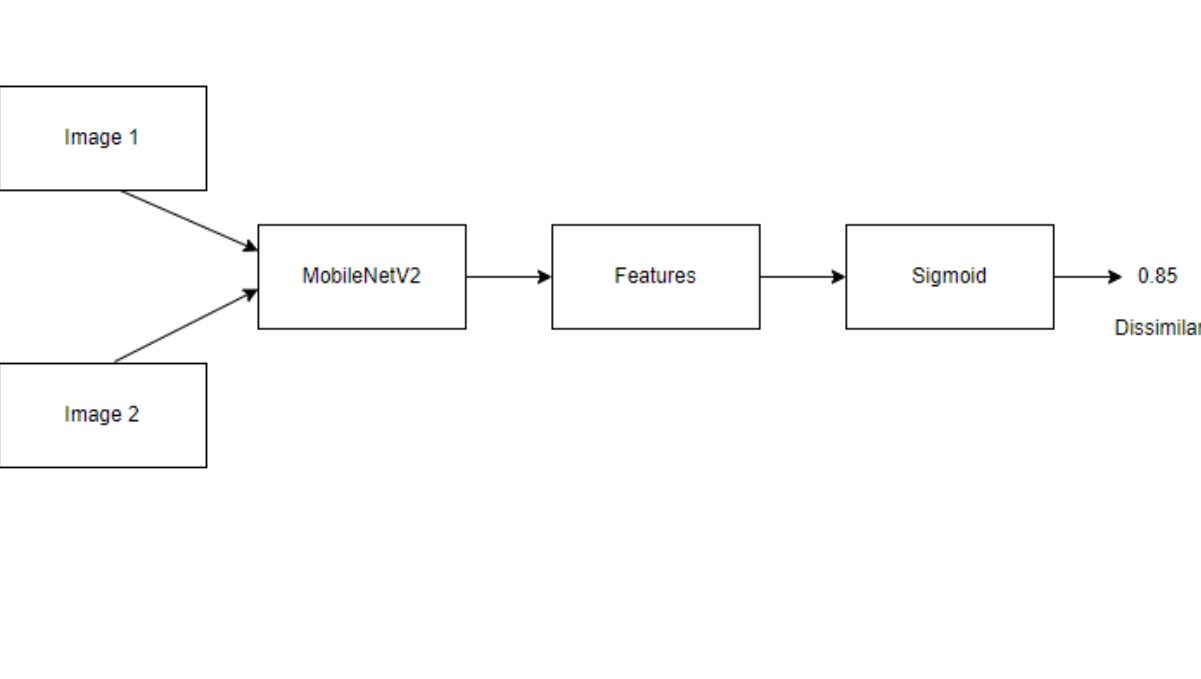
Fig. 2 . Flowchart for Disaster detection using Satellite